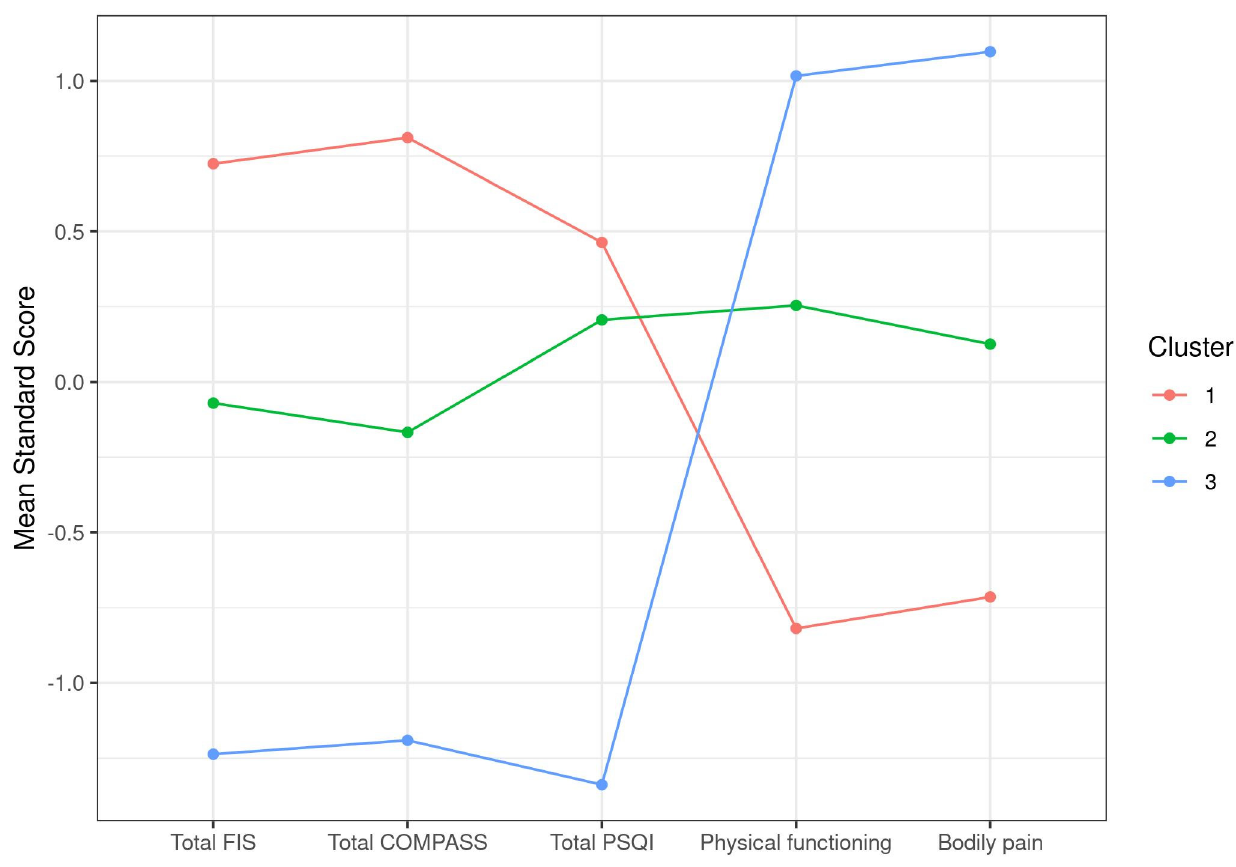
Figure 1. Graphic representation of ME/CFS clustering according to symptom standard mean scores.